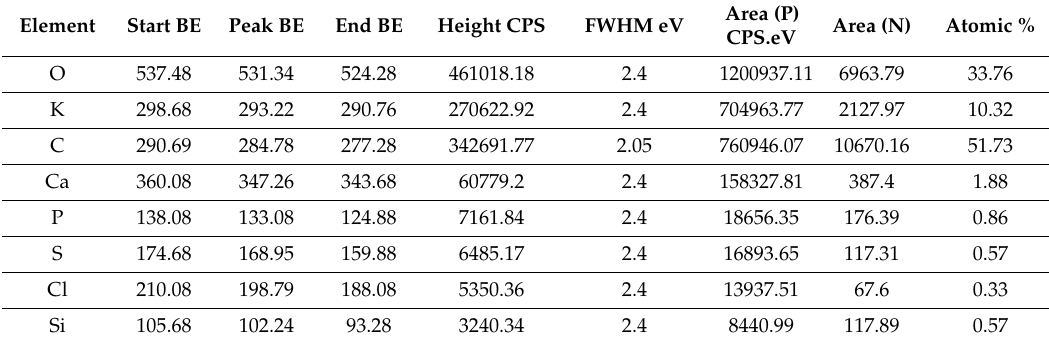
Table 2. XPS analysis.